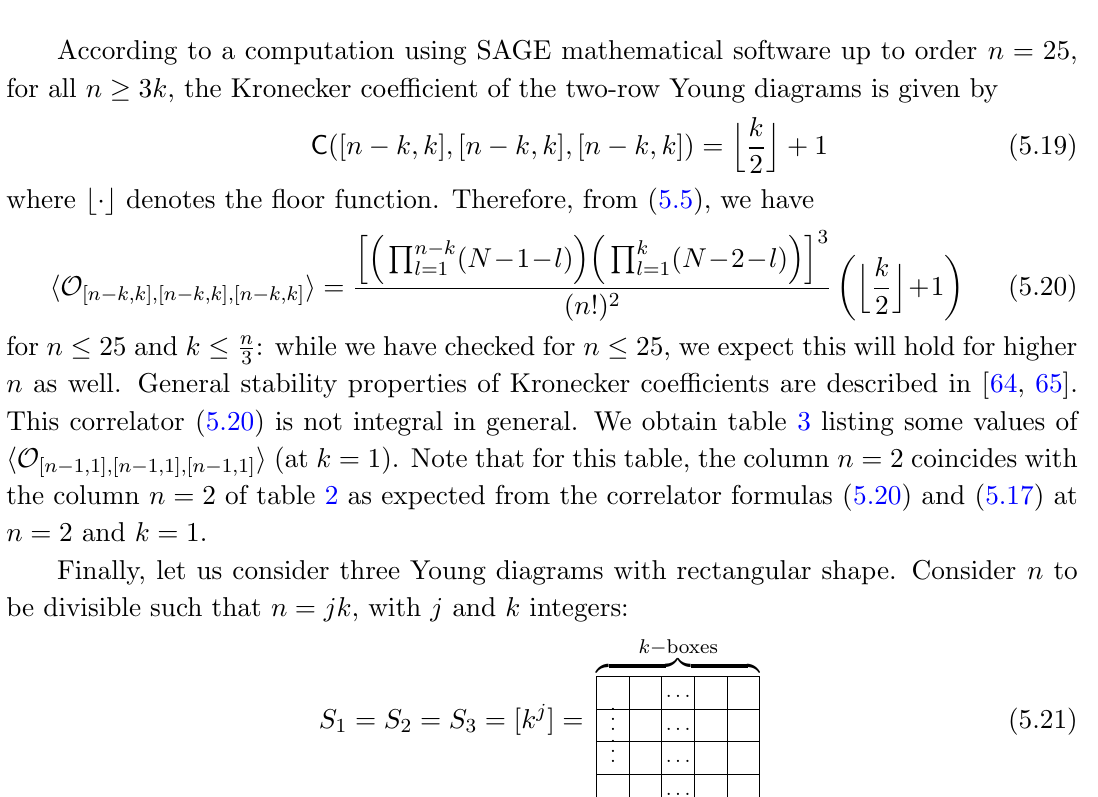
Table 3 . Evaluation of hO